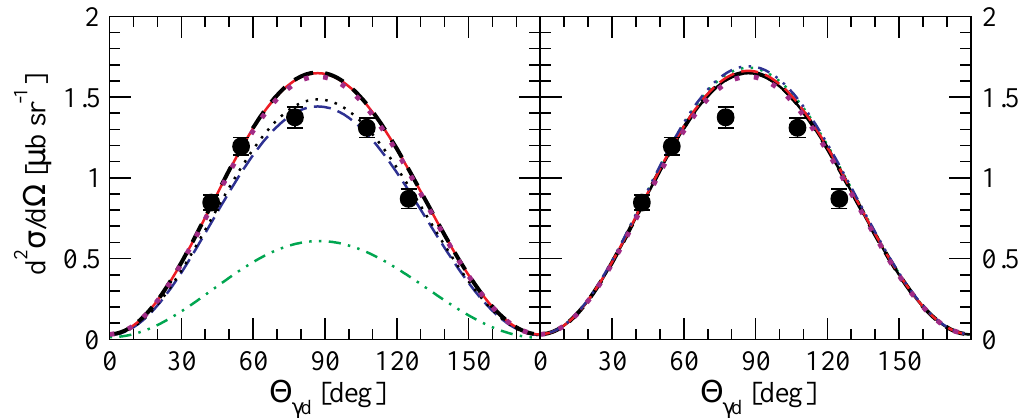
Figure 2: The differential cross section d 2 σ/ d Ω for the n + d → γ + 3 H reaction at = 9 MeV as a function of the center-of-mass angle the neutron laboratory energy E n Θ γ d between the initial deuteron and final photon momenta obtained with the chiral NN potential [ 25, 26 ] and the Siegert theorem [ 53 ] . In the left panel various lines show predictions from Ref. [ 57 ] with the fixed cut-off parameter R = 0.9 fm at various orders of chiral expansions: LO (double-dotted-dashed green), NLO (dashed blue), N2LO (dotted black), N3LO (solid red) and N4LO (thick dashed black). In the right panel the lines show N4LO predictions for various cut-off parameter values R : 0.8 fm (dotted green), 0.9 fm (thick dashed black), 1.0 fm (solid black), 1.1 fm (dashed red) and 1.2 fm (double-dotted-dashed blue). In both cases we added our predictions based on the AV18 NN potential [ 2 ] , represented in the two panels by the thick violet dotted curve. The data are from Ref. [ 58 ]